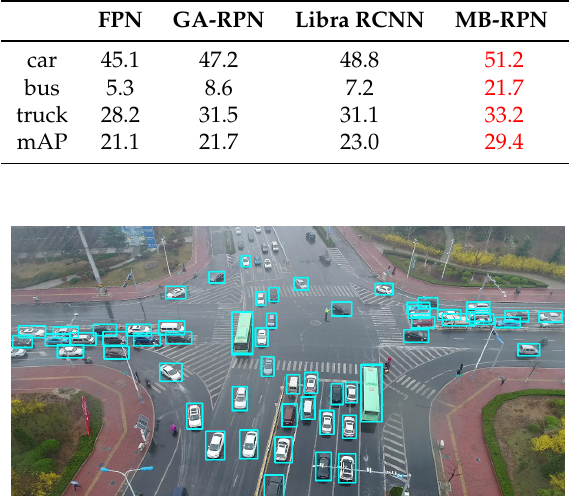
Table 3. Quantitative performance(AP%) of our model on UAVB benchmark datasets compared with comparison approaches. The best performance on each category is colored in red.